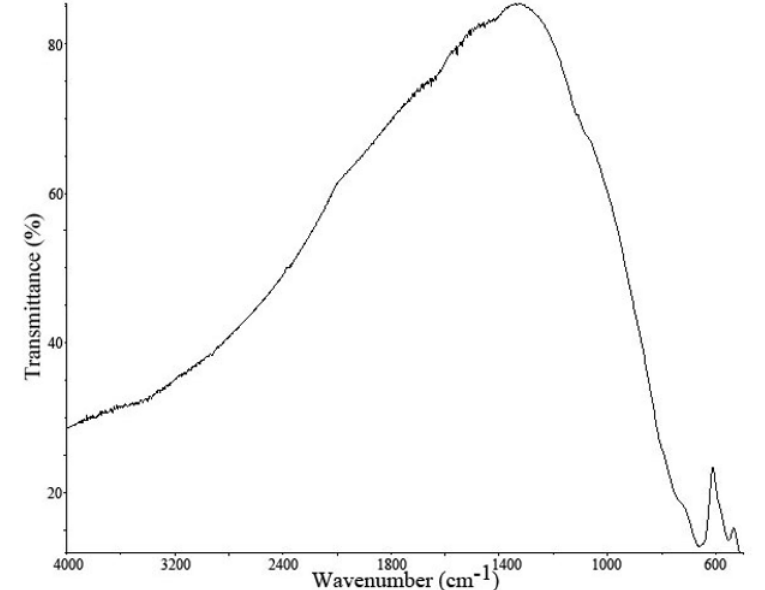
Figure 6. Infrared spectrum of CoAl